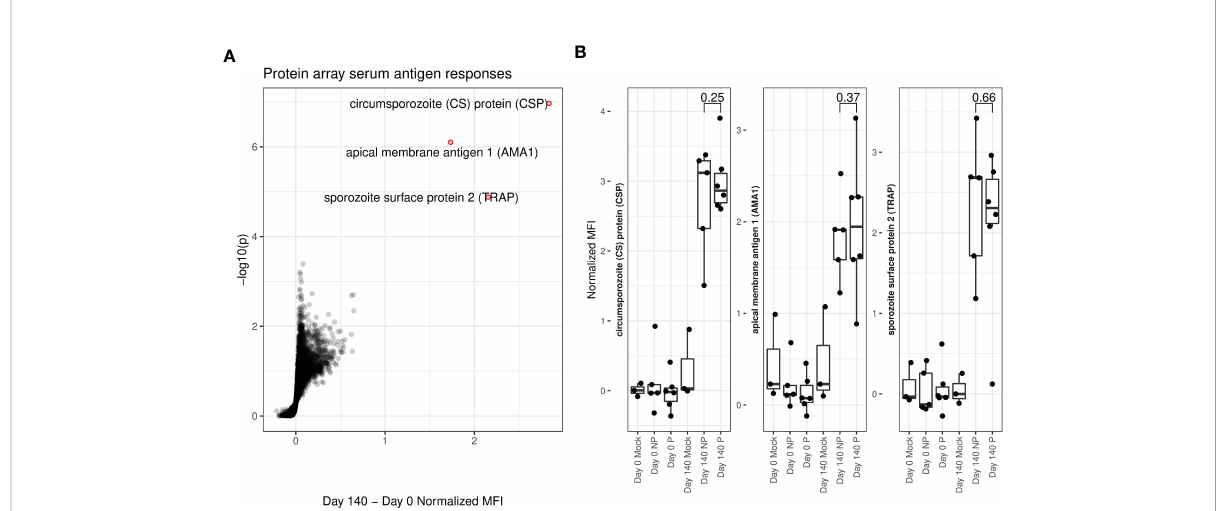
FIGURE 1 Protein array determined serum antigen responses. (A) Volcano plot. X-axis shows increase in protein array normalized mean fl uorescent intensity (MFI) from pre-immunization (day 0) to immediately pre-challenge (day 140) timepoints for RAS-immunized participants. Y-axis shows matching log-transformed false-discovery rate (FDR) adjusted single-tailed t-test p-values. Signi fi cant (FDR < 0.05) and highly increased (MFI increase > 1) antibody responses are highlighted with red circles and labelled with the corresponding protein. (B) Box and dot-plots of pre- vaccine and pre-challenge MFIs for each study participant for labelled antibody responses from (A) shown separately for protected (P) and non-protected (NP) RAS vaccine recipients. Mock immunized individuals are included for reference. T-test p-values comparing pre-challenge antibody binding MFIs between P and individuals are